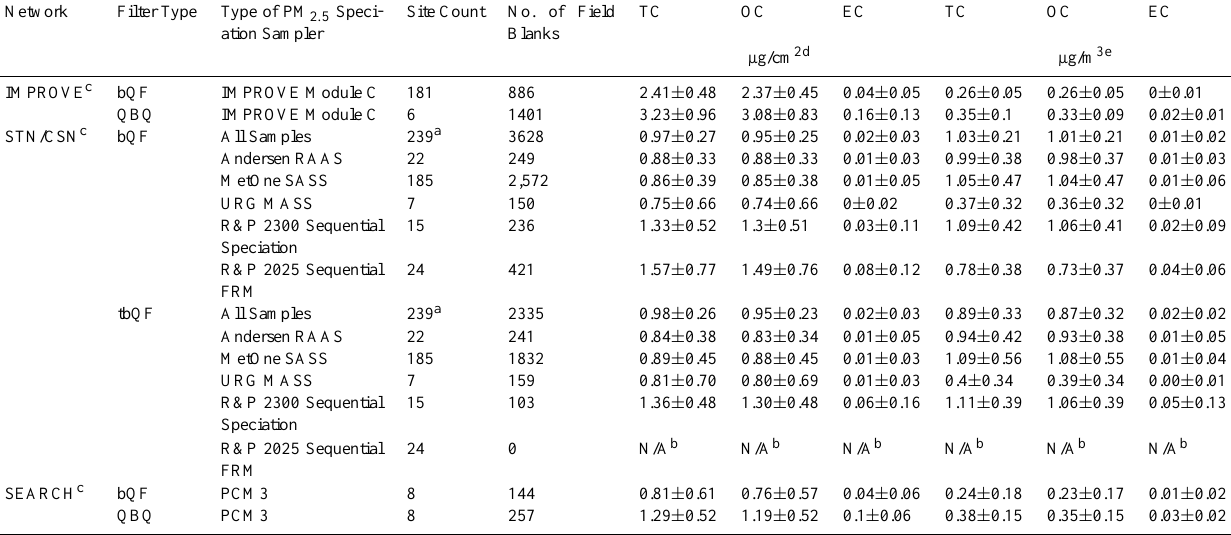
Table 3. Comparison of average field blank (bQF), trip blank (tbQF), and backup (QBQ) filter carbon levels ( ± standard deviation) among the IMPROVE, STN/CSN, and SEARCH networks for the period from 1 January 2005 to 31 December 2006.